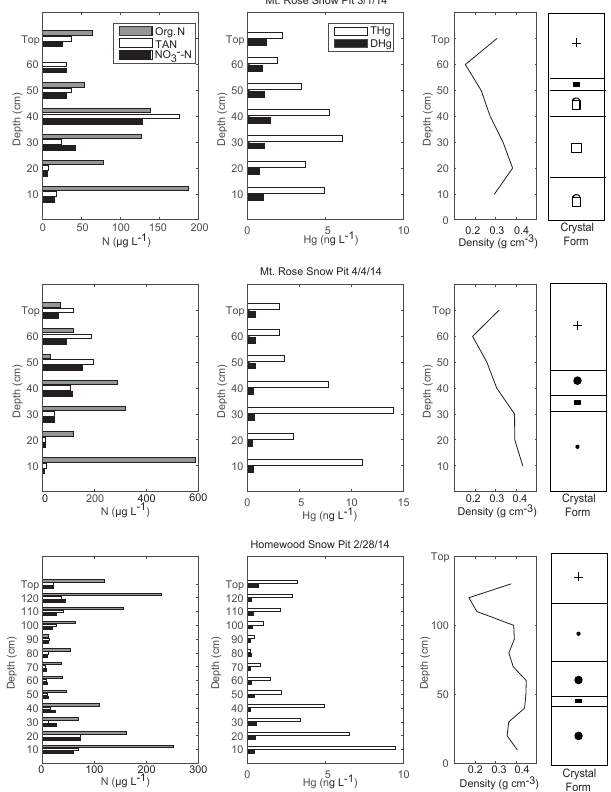
Figure 6. Year 2013–2014 snow pit profiles for nitrogen and mer- cury species concentrations, snow density, and crystal form. Crystal classifications are based on the ICSI classification for seasonal snow on the ground (Fierz et al.,